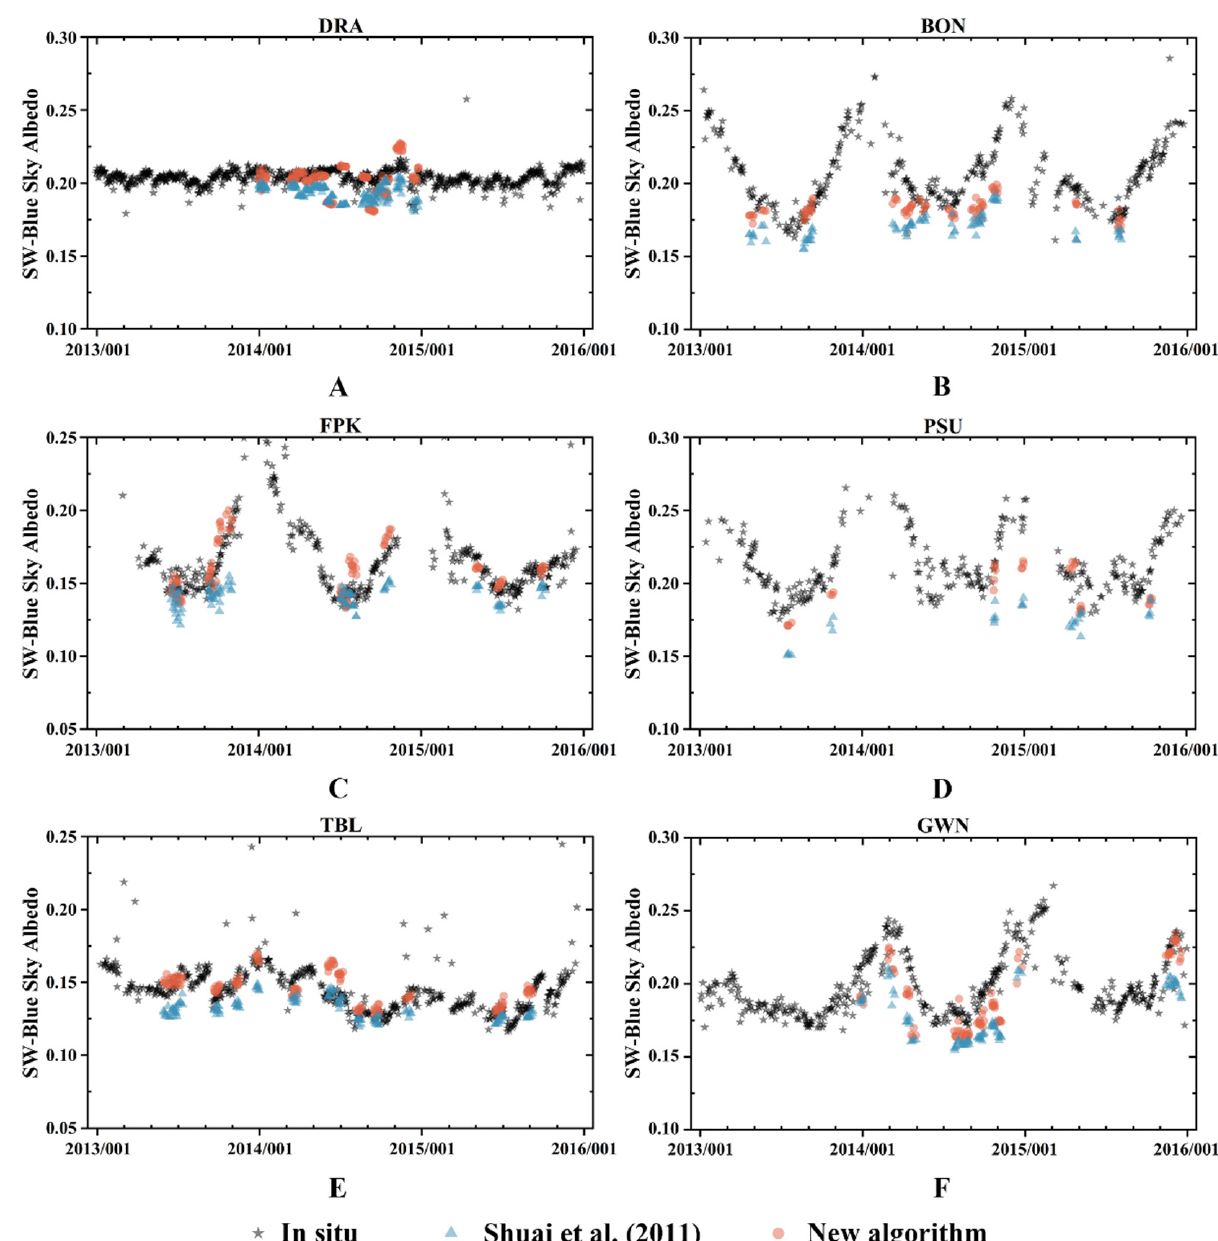
Figure 5. Time series comparison of in situ albedo of six sites against concurrent approach and new algorithm albedo from 2013 to 2015. ( A ): Desert Rock (DRA); ( B ): Bondville (BON); ( C ): Fort Peck (FPK); ( D ): Penn State University (PSU); ( E ): Table Mountain (TBL); ( F ): Goodwin Creek (GWN).